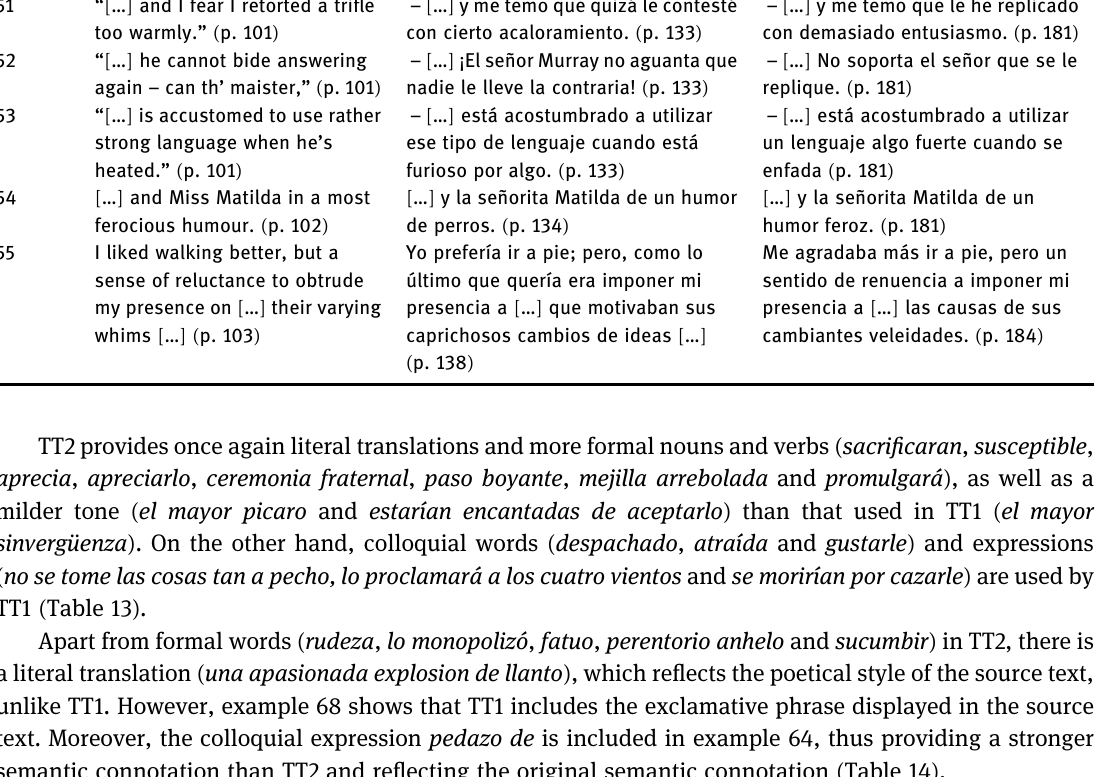
Table 11: Examples taken from Chapters 12 and 13 Example ST